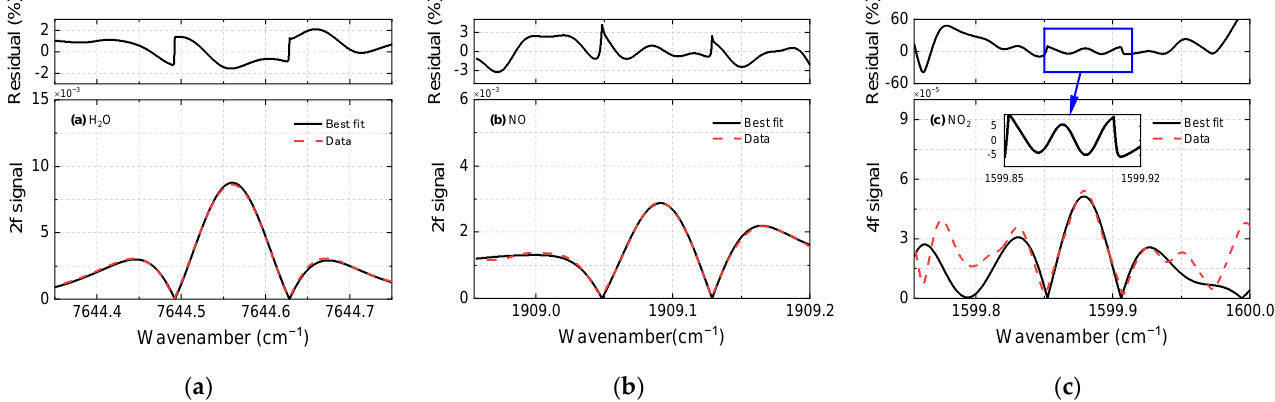
Figure 9. Measured (red dashed line) and best-fit (black solid line) harmonic line shapes for ( a ) H 2 O, ( b ) NO, and ( c ) NO 2 in a combustion exhaust at Φ = 0.89.